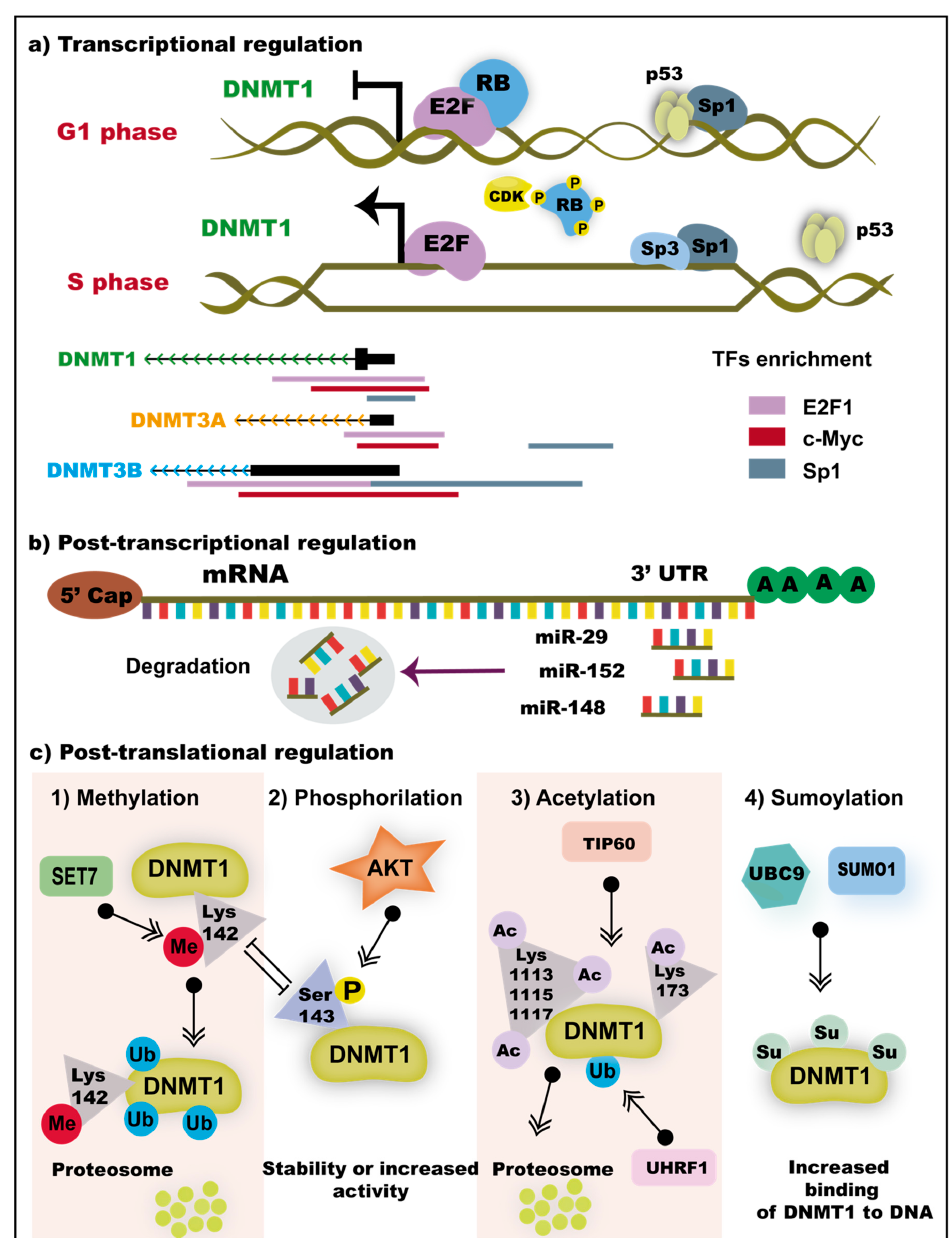
Figure 2. Transcriptional regulation and post-transcriptional modifications of DNMT1. ( a ) The expression of DNMTs increases in the transition from phase G1 to S. In phase G1, p53 interacts with Sp1, and pRB is dephosphorylated and bound to E2F. During replication, the levels of p53 decrease and CDKs expression increases, which results in the dissociation of pRB phosphorylated from E2F and p53 from Sp1; this facilitates DNMT1 transcription activation. DNMT1, DNMT3A, and DNMT3B promoters are enriched with Sp1, E2F, and c-Myc transcription factors (TFs) in several cell lines analyzed in the ENCODE project. ( b ) Post-transcriptional regulation of DNMTs mRNA occurs through the interaction of miRNAs with its 3 (cid:48) UTR end. The binding of miR-29, miR-152, and miR-148 leads to the degradation of DNMT1 mRNA. ( c ) Post-translational modifications of DNMT1 may favor its activity or degradation. Methylation of lysine 142 by the methyltransferase SET7 leads to the ubiquitination of DNMT1. This modification is mutually exclusive with the phosphorylation of serine 143 by AKT, which favors the stability and activity of DNMT1. The acetylation performed by TIP60 in several lysine residues in combination with the ubiquitination made by UHRF1 leads consequently to the DNMT1 degradation via proteasome. The binding of DNMT1 to DNA can be increased by the sumoylation performed UBC9 and SUMO1. Me, methylation; P, phosphorylation; Ub, ubiquitination; Su, sumoylation; Lys, lysine; Ser,